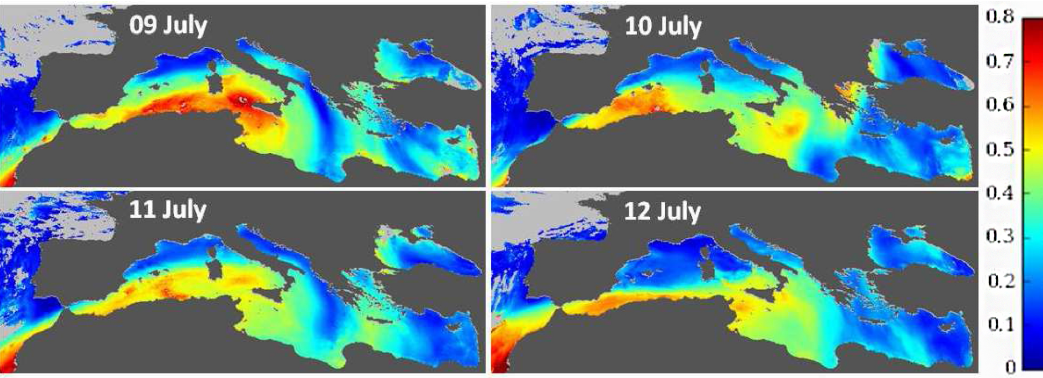
Figure 5. Daytime (from 04:00 to 18:00UTC) mean AOD at 550nm derived from MSG/SEVIRI. Table 4. Statistics (see Appendix A) of the simulation results for the different networks. Network Species Simulation Stations Obs. 1 mean Sim. 2 mean RMSE µgm − 3 µgm − 3 µgm − 3 % BDQA PM 10 Without DA 240 With DA PM 2 . 5 Without DA With DA Barcelona PM 10 Without DA PM 2 . 5 With DA EMEP-Spain/Portugal PM 10 Without